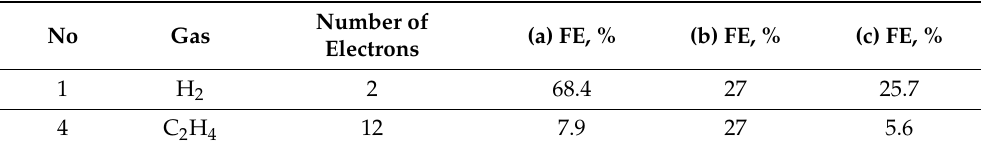
Figure 4. XRD curves of oxidised copper foil (red) and electrochemically deposited Cu coating on GDL/N-GSS before (blue) and after (black) 1 h electrolysis. Table 1. FE of hydrogen and ethylene in gas products from catholyte chamber for selected 3